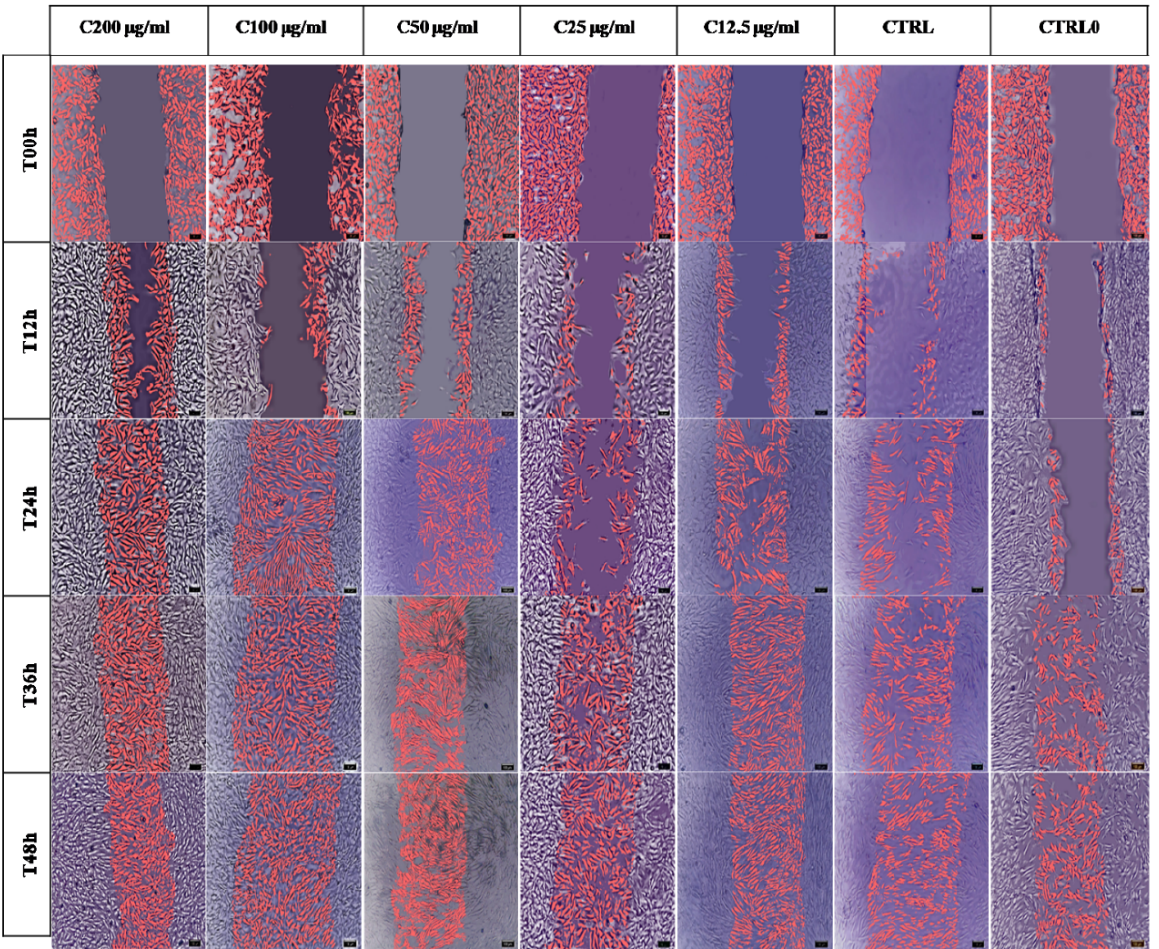
Figure 4. The evolution over time (0, 12, 24, 36, and 48 h) of cell wound coverage at different concentrations of Stellaria media (L.) Vill extract (range 200 µ g/mL–12.5 µ g/mL) compared to positive control (CTRL)—treated with allantoin 50 µ g/mL and untreated wound control (CTRL0). Fibroblasts marked in pink are those that have mobilized into the wound. The scale of the processed images is 100 µ